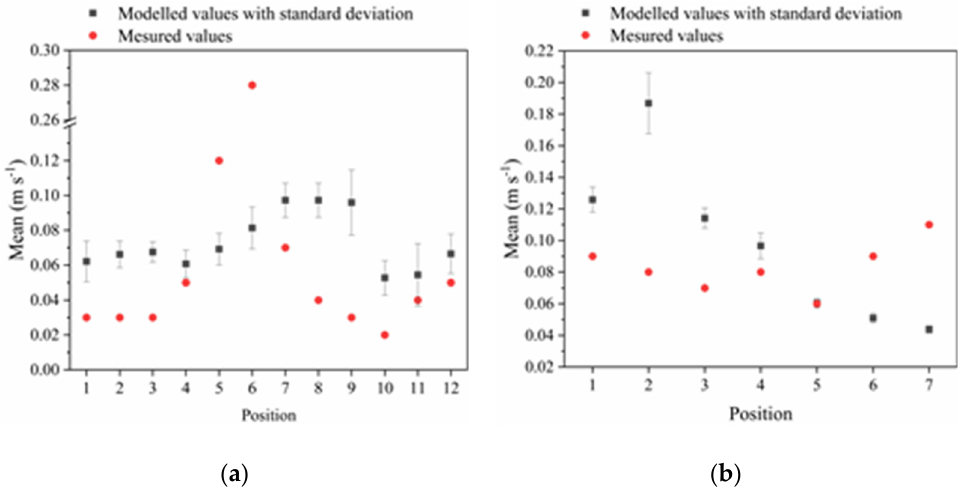
Figure 9. Measured and modelled air velocities at the measured positions for ( a ) “flower”, ( b ) “island of four”.